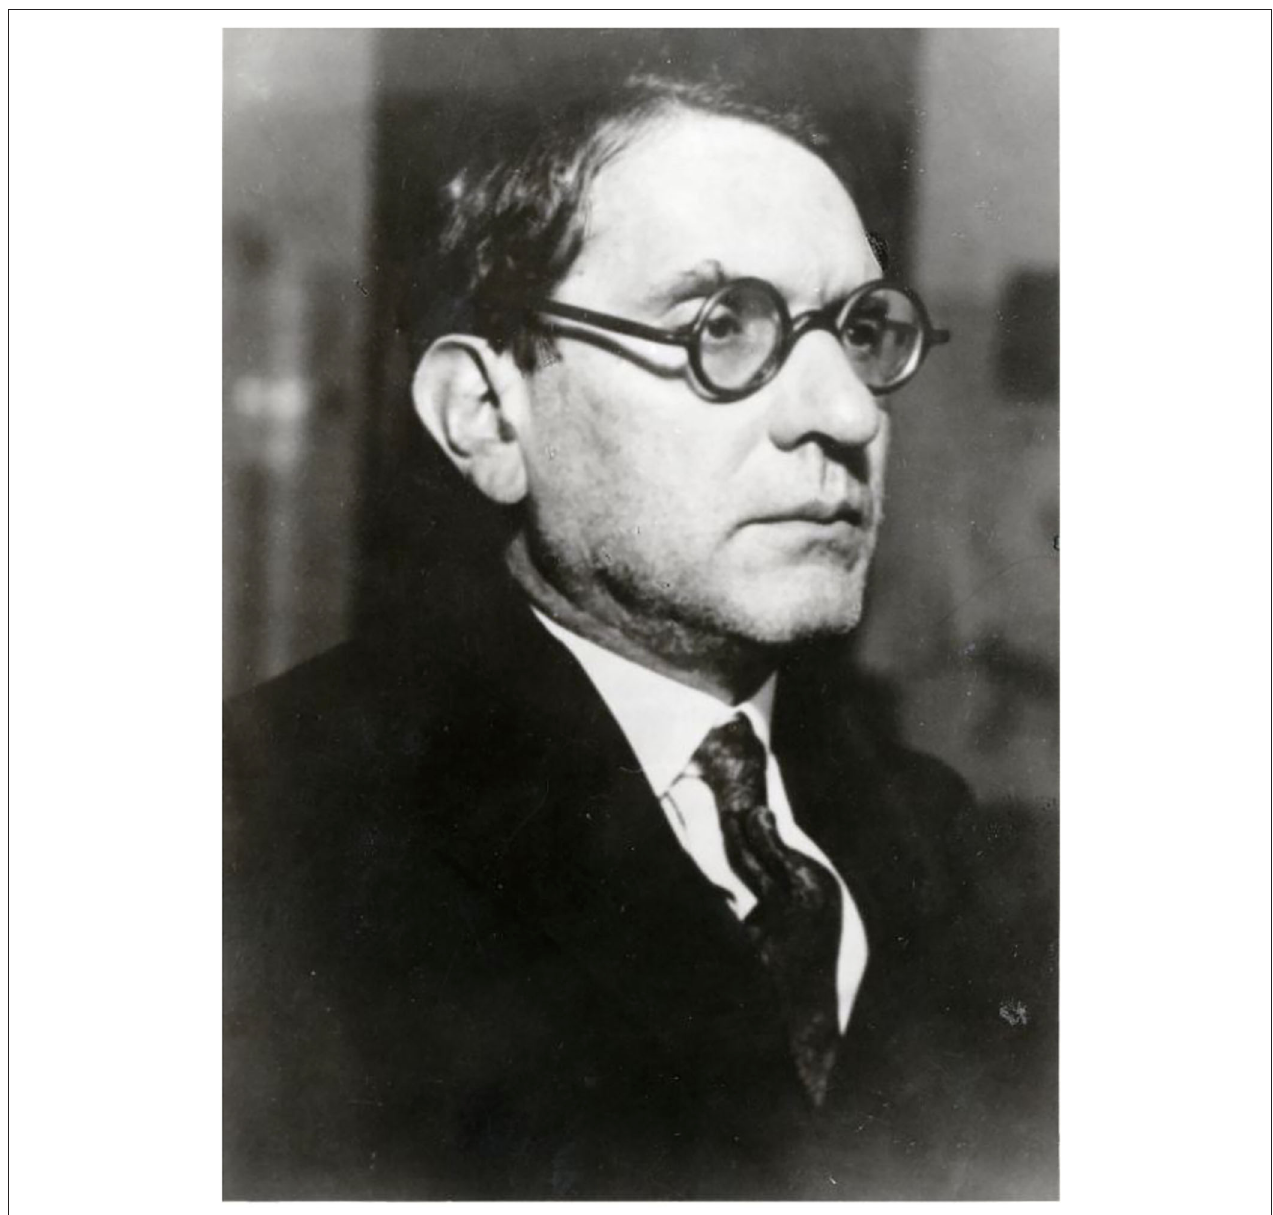
FIGURE 4 | Otto Pötzl (1877-1962), Austrian neurologist and psychiatrist. Source: Image Archive of the Sigmund Freud Foundation, Vienna,